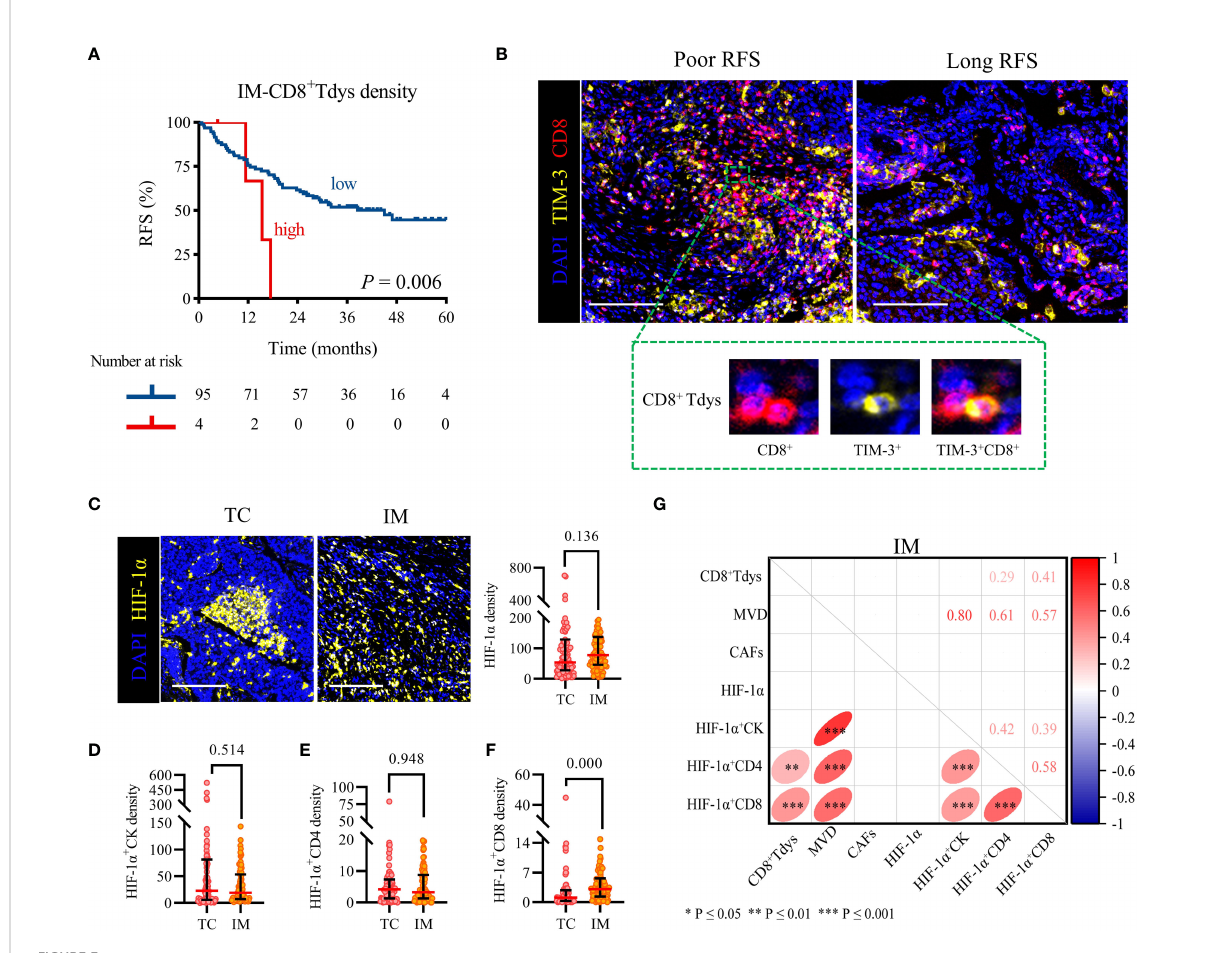
FIGURE 3 High IM-CD8 + Tdys density was associated with the recurrence of the locally advanced NSCLC, and HIF-1 a + CD8 may contribute to the accumulation of CD8 + Tdys. (A) Kaplan – Meier curves illustrate the associations between the expression levels of IM-CD8 + Tdys (high vs low) and the RFS of locally advanced NSCLC. P -values re fl ect comparisons of two groups by univariate analysis, using the log-rank test. (B) Representative image for poor RFS (left) and long RFS (right). Scale bar, 100 m m. (C – F) The heterogeneity of HIF-1 a (C) , HIF-1 a + CK (D) , HIF- 1 a + CD4 (E) , and HIF-1 a + CD8 (F) density between TC and IM regions. Scale bar, 100 m m. Signi fi cance was determined using the Mann-Whitney test, all data are presented as the median and interquartile ranges. (G) Spearman correlation between CD8 + Tdys and HIF-1 a , MVD, CAFs density in the IM